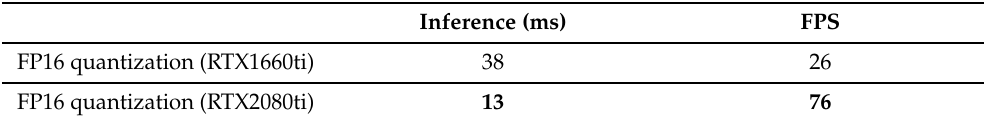
Table 6. Comparison of reasoning speed of different